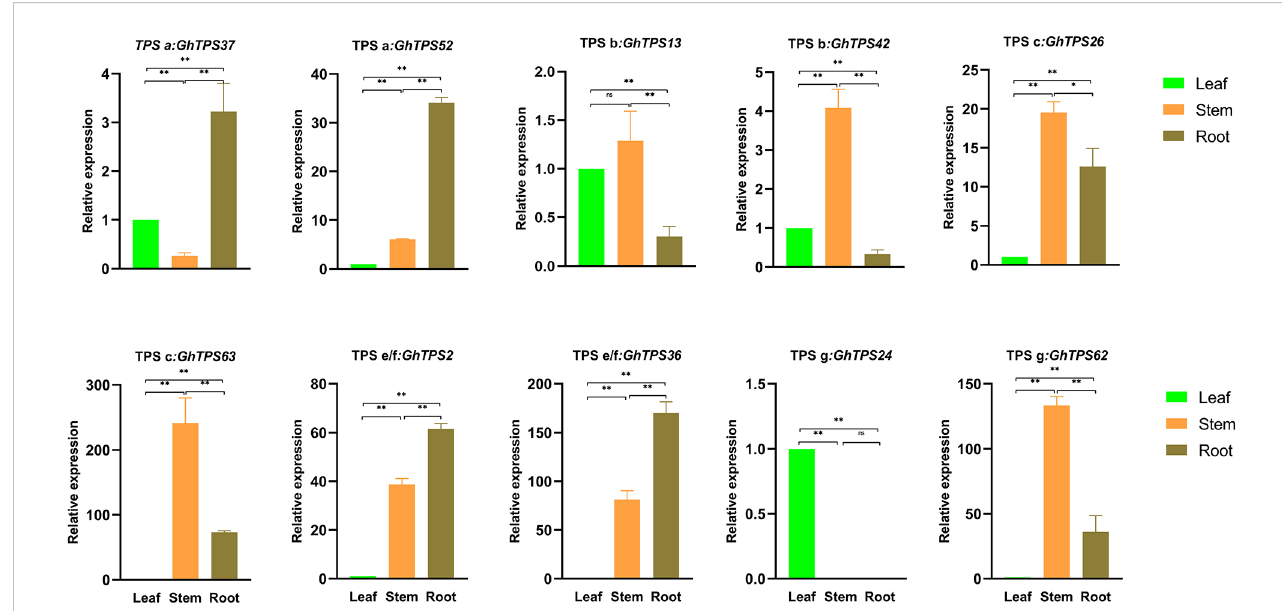
FIGURE 9 Tissue-speci fi c expression of 10 GhTPSs. Error bars are the standard deviation (SD) of biological replicates. ns, p>0.05, *0.05>p>0.01,